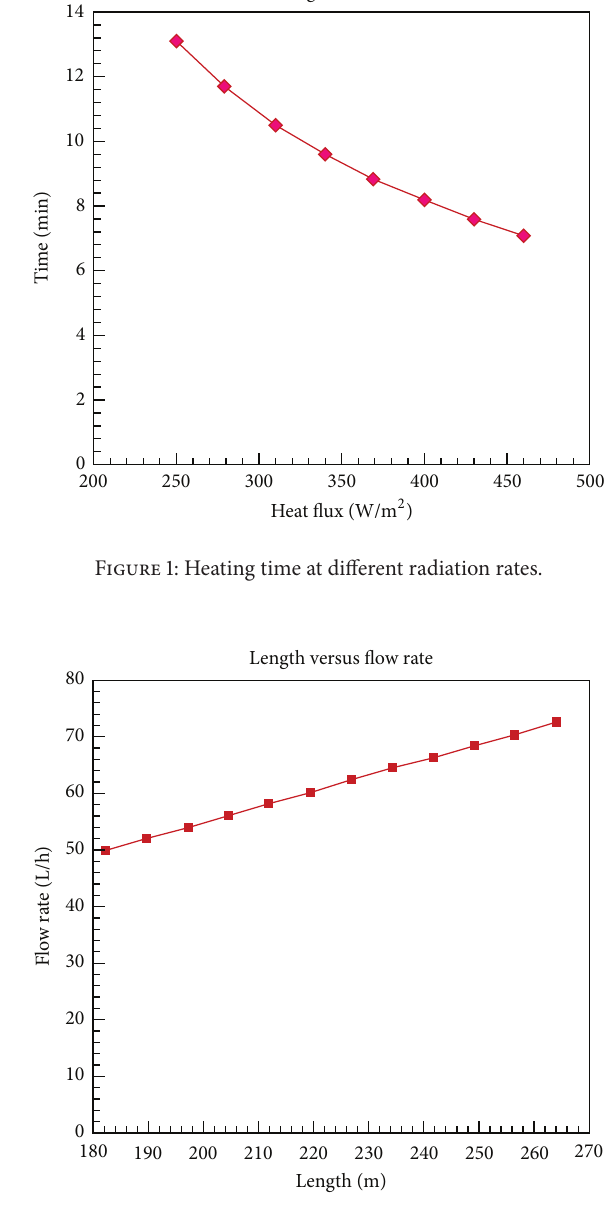
Figure 2: Flow rate and length relation at constant heat